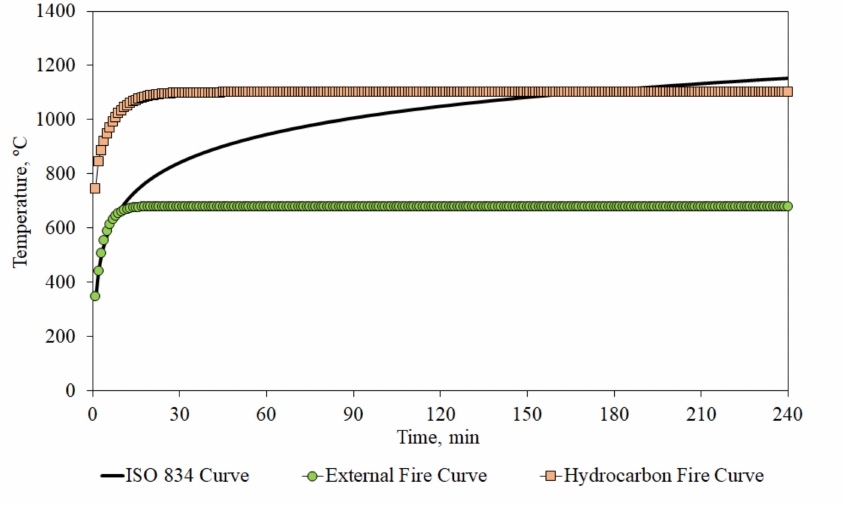
Figure 3. Nominal temperature-time